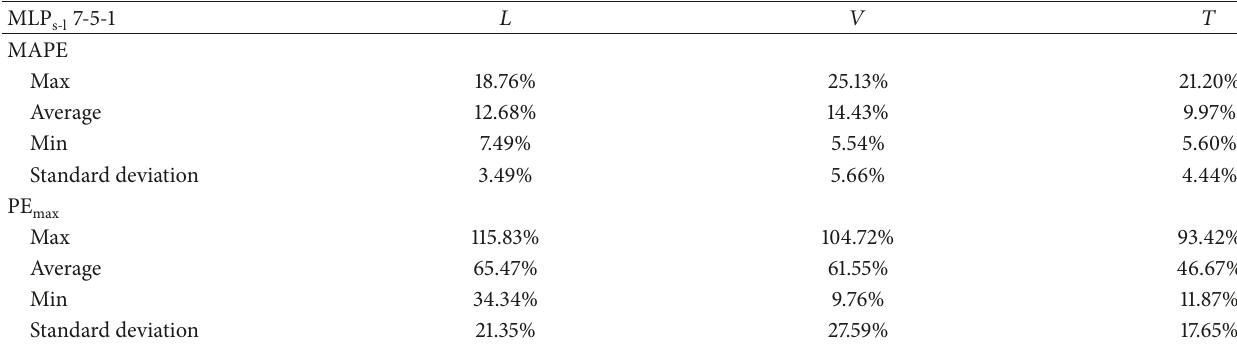
7-5-1 (source: own s-l